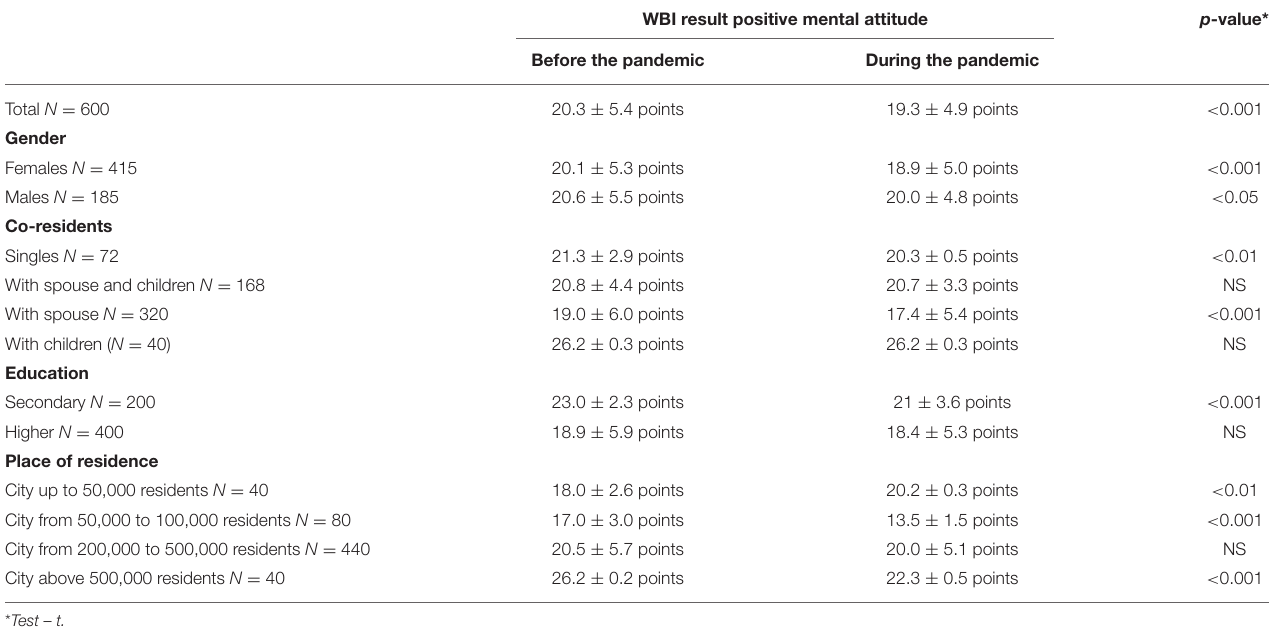
TABLE 8 | Assessment of positive mental attitudes before and during the pandemic by gender, education, co-residents and place of residence.